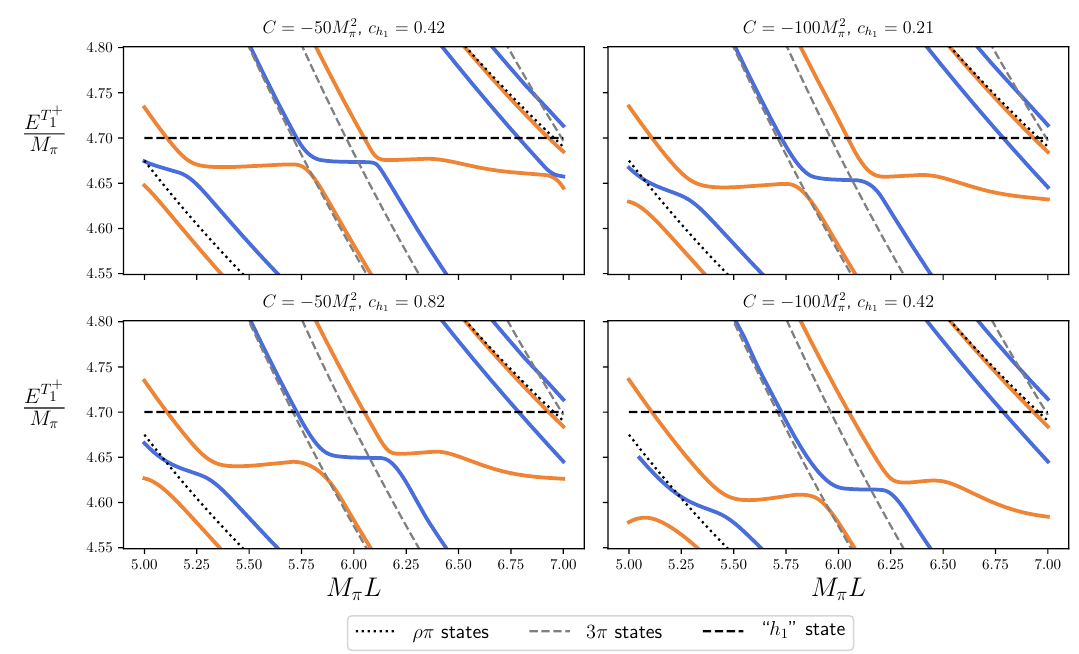
Figure 5 . Finite-volume energies for various scattering parameters in the T + focus on energies close to the toy h 1 resonance. As explained in the text, changing either C or c h changes the physical three-particle scattering amplitude while leaving the pole in bottom right panel corresponds to the parameters of the (cid:12)gure